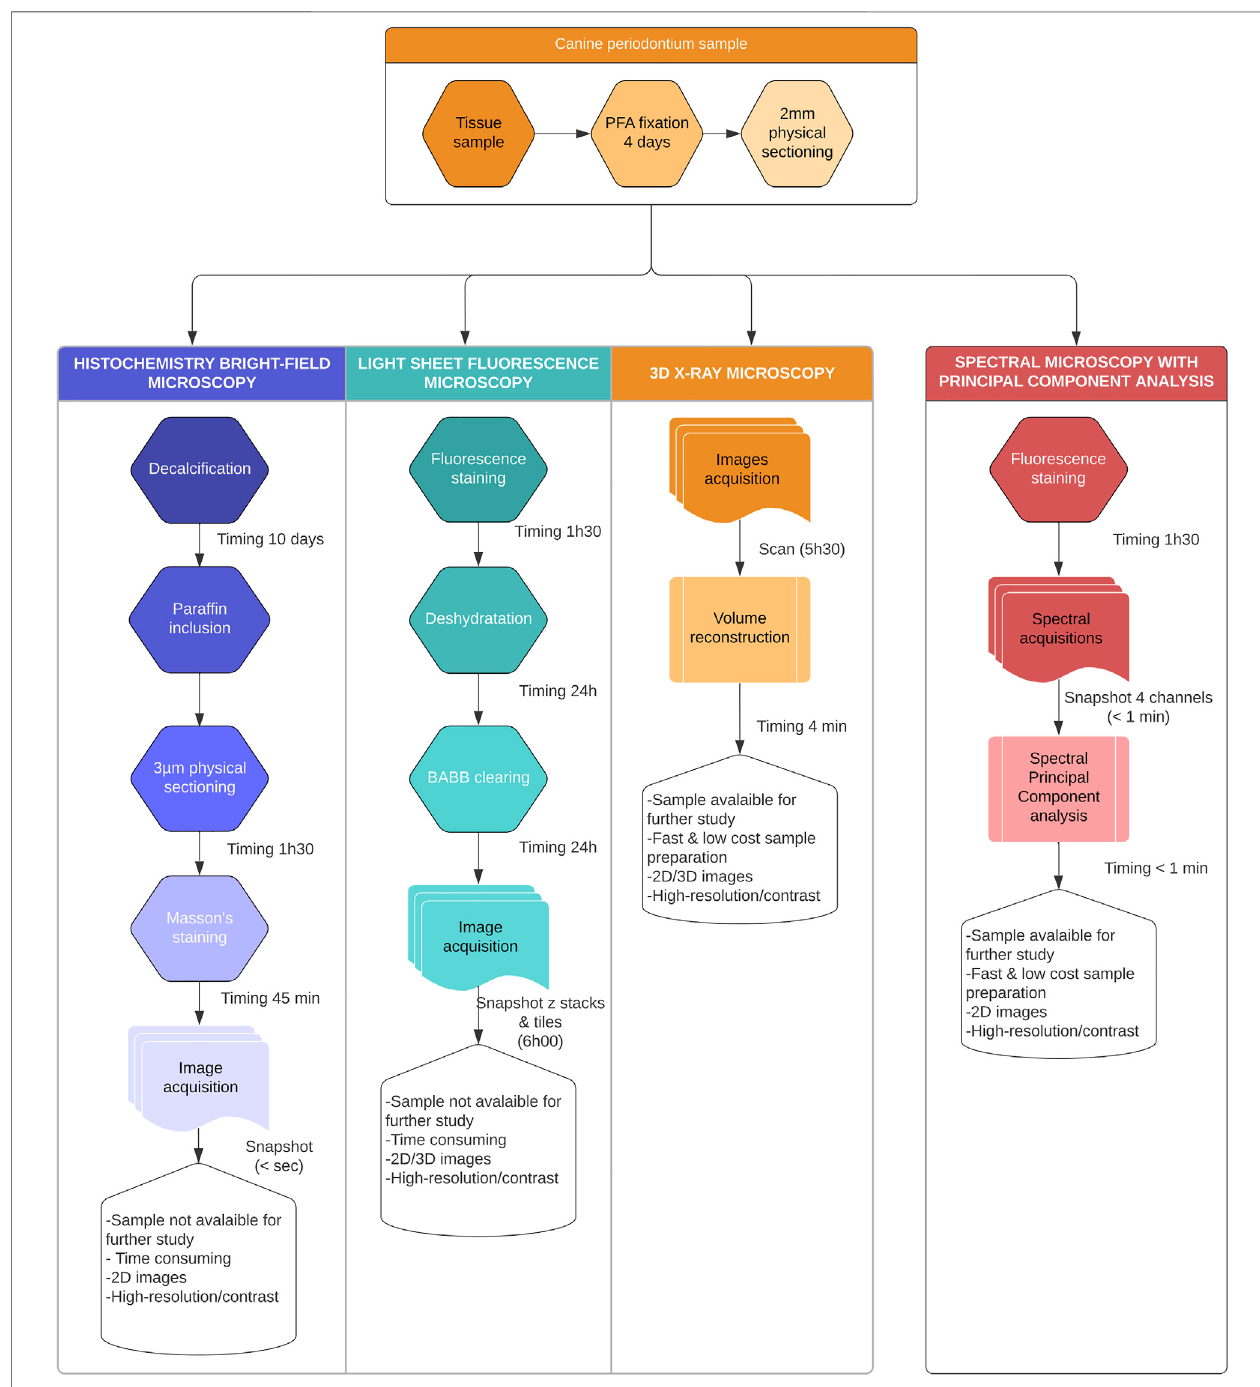
FIGURE 1 | Summary of the sample processing. All samples were processed using conventional bright- fi eld microscopy, 3D X-Ray microscopy, Light Sheet microscopy (LSM), and compared to the Spectral Principal Component Analysis (sPCA). Pros and cons were presented for each method, revealing the unique contribution of sPCA as a fast and scalable